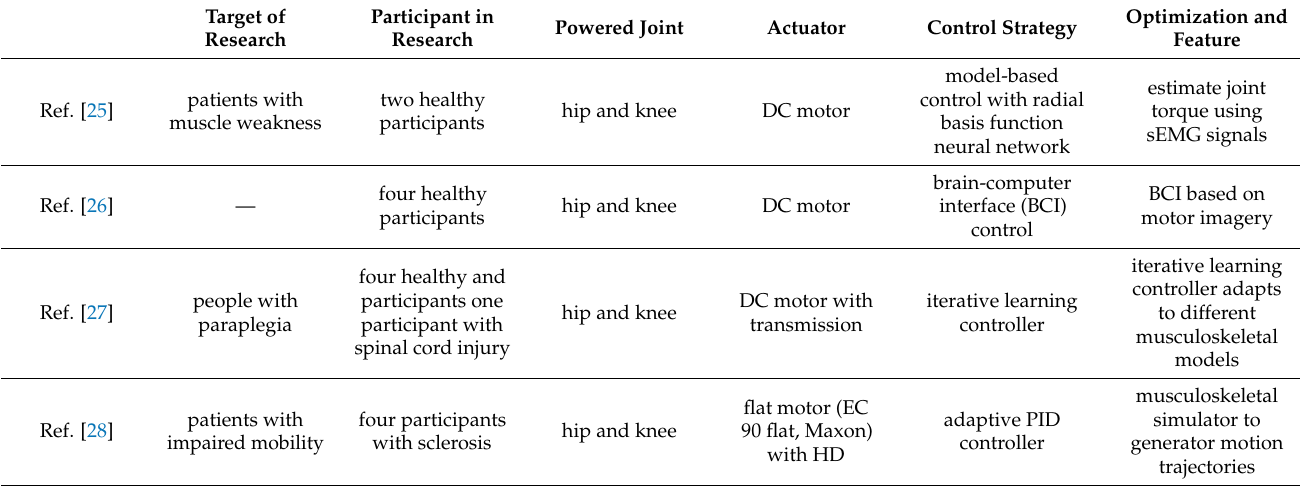
Table 2. Difference between previous studies and the current